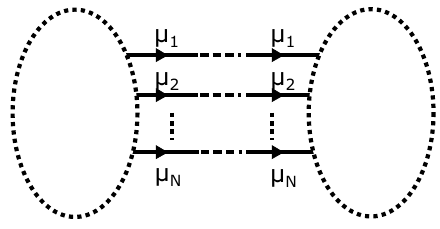
Figure 59. The diagram of the usual SU( N )